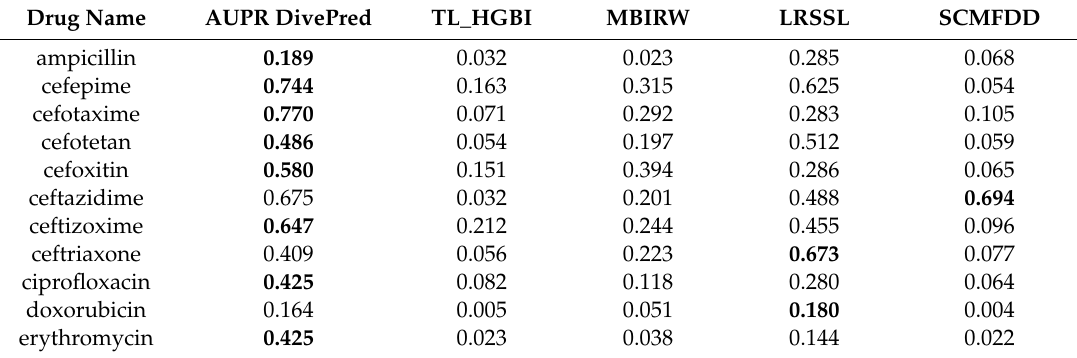
The bold values indicate the higher AUCs. Area under precision–recall curve (AUPR) values of 15 drugs using DivePred and other